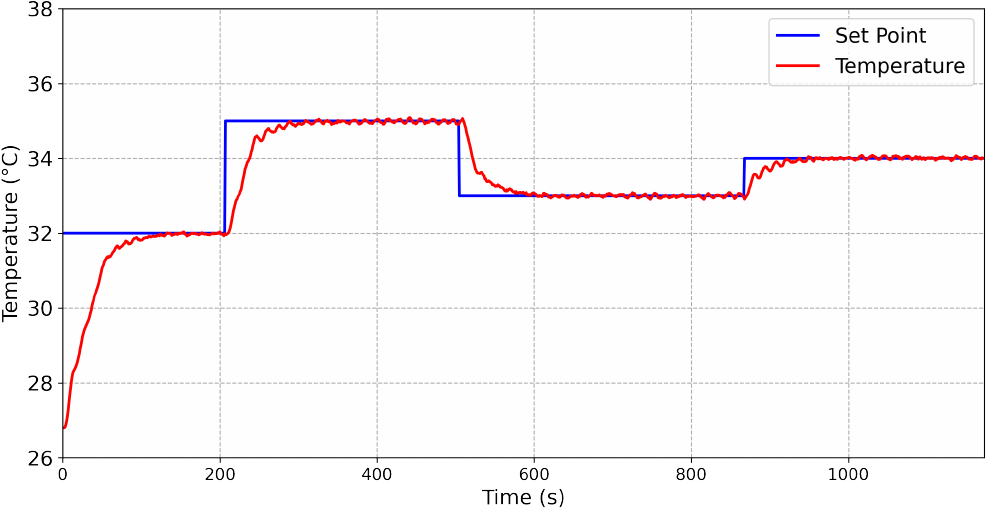
Figure 9. Relationship between the set-point (blue line) and the emulated temperature (red line) for the step response of the proposed Fuzzy controller.